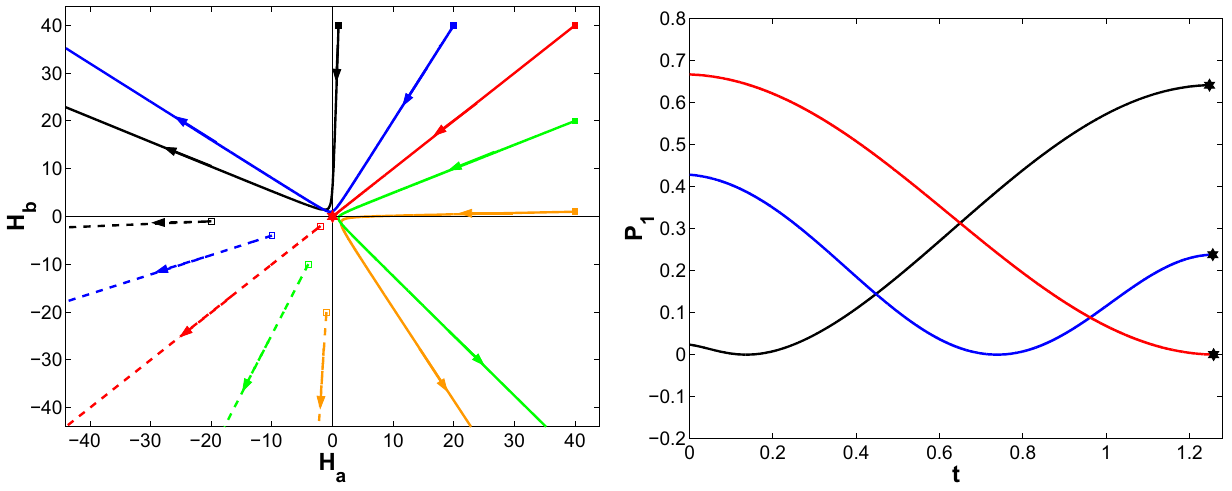
Fig. 6 The phase portrait (left) and the evolution of the dimension- less parameter P 1 ( t ) (right) for N = 2, f 0 = − 1 . Initial values of 12 H a ( 0 ) , H b ( 0 ) are 1).-5). for solid curves and 6).-10). for dashed those: 1). H a ( 0 ) = 1, H b ( 0 ) = 40 (black), 2). H a ( 0 ) = 20, H b ( 0 ) = 40 (blue), 3). H a ( 0 ) = 40, H b ( 0 ) = 40 (red), 4). H a ( 0 ) = 40, H b ( 0 ) = 20 (green), 5). H a ( 0 ) = 40, H b ( 0 ) = 1 (orange), 6). H a ( 0 ) = −